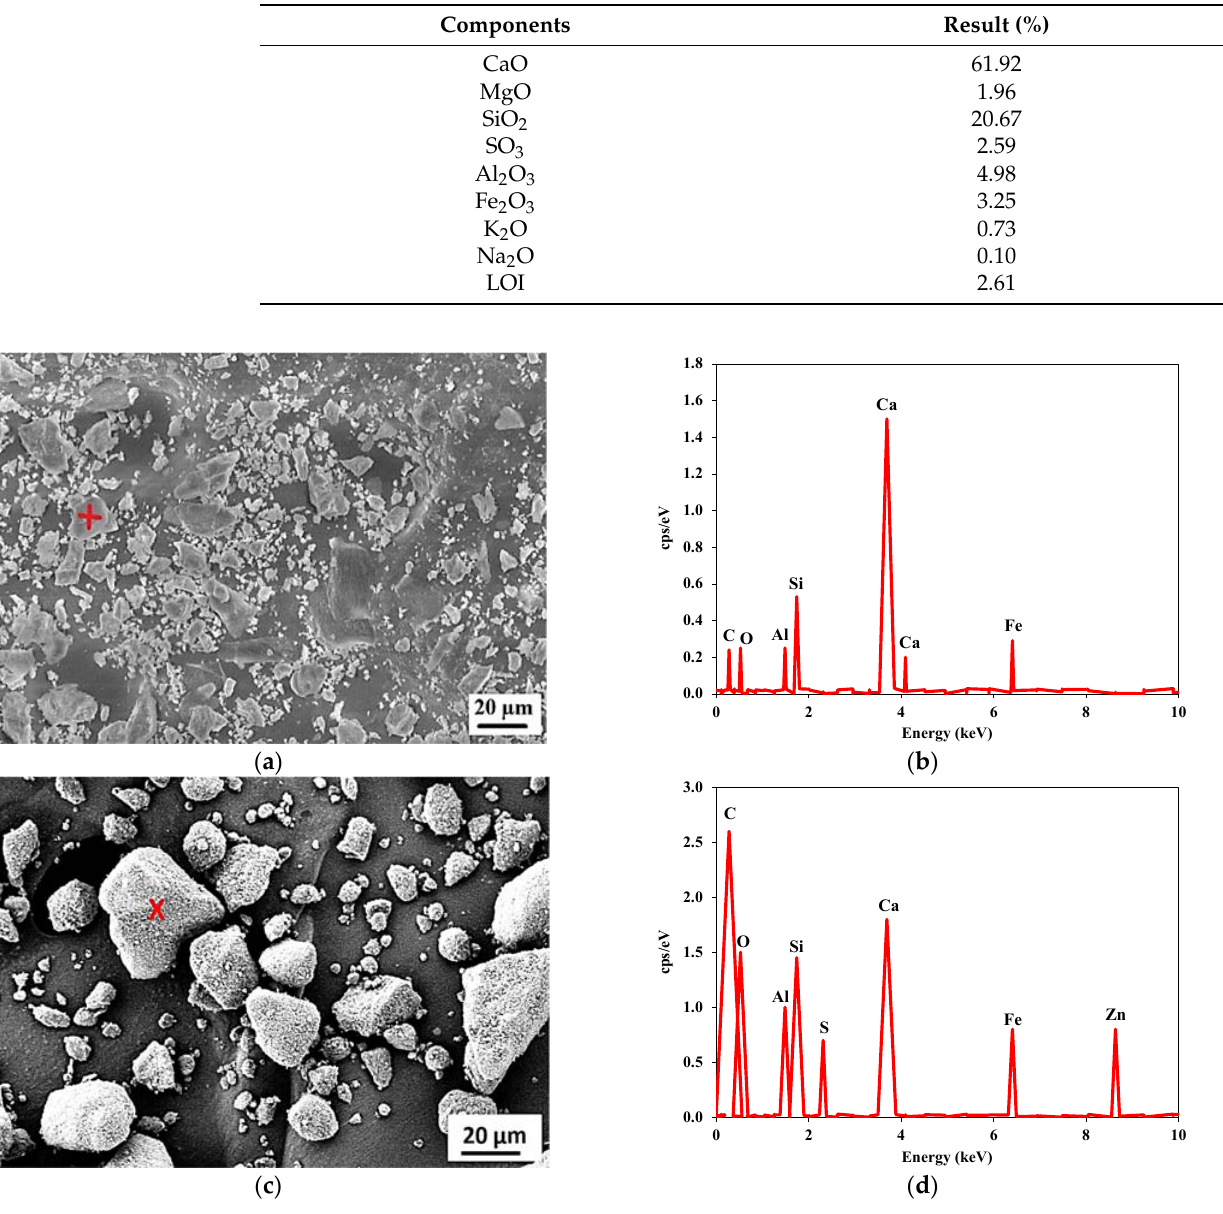
Figure 3. SEM and EDX analysis of used cement and rubber. ( a ) Cement; ( b ) EDX of cement ( + ); ( c ) Rubber waste; ( d ) EDX of rubber waste ( x ).